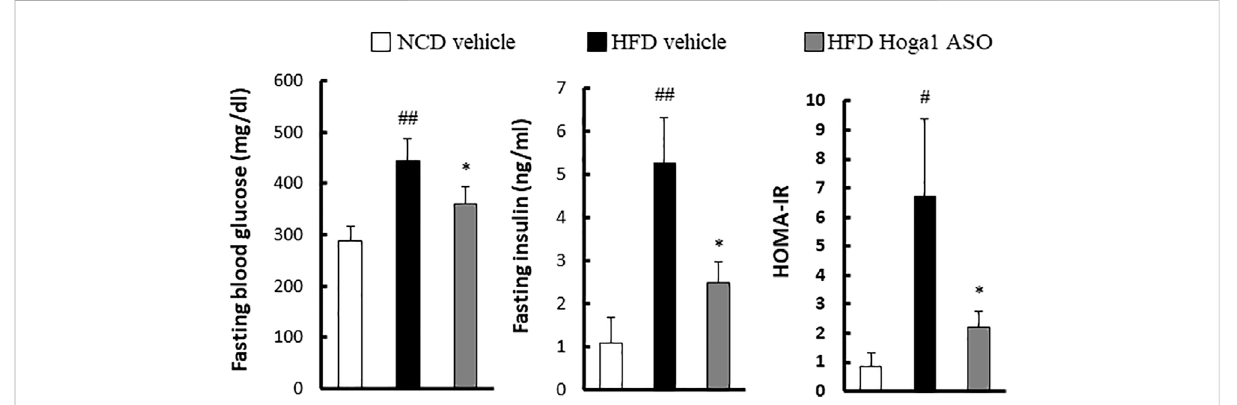
FIGURE 7 Theeffectof Hoga1 knockdownonclinicalindexesofinsulinresistanceinobesemice.Fasting bloodglucose,seruminsulinconcentration,and HOMA-IRwerecomparedamongtheNCDvehicle,HFDvehicle,andHFDHoga1ASOgroups(N=6pergroup).Resultsareexpressedasthemean± SD of three independent experiments ( # p < 0.05 and ## p < 0.01 indicate signi fi cant differences between the NCD vehicle and HFD vehicle, respectively; * p < 0.05 indicates a signi fi cant difference between the HFD vehicle and HFD Hoga1 ASO).